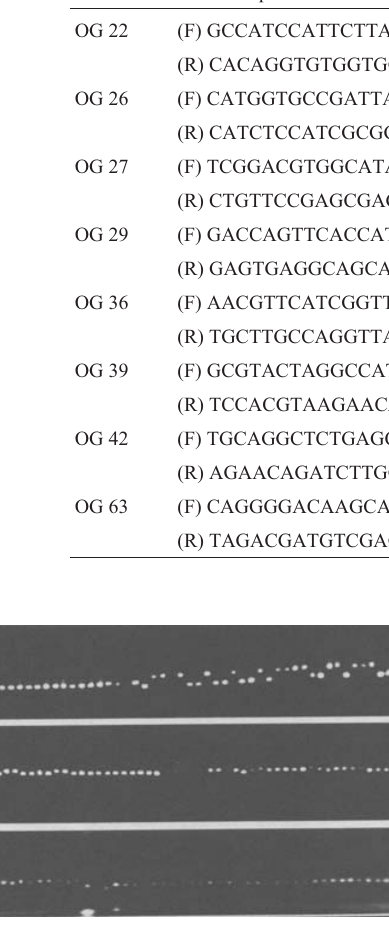
Figure 2 - Non-denaturing polyacrylamide gels of Oryza glumaepatula populations, in the following order: (A) primer OG-26, pop. PU-1 (left) and SO-4 (right); (B) primer OG-26, pop. NE-18 (left) and TA-1 (right), (C) primer OG-29, pop. PU-1 (left) and SO-4 (right). Ladders (10 bp and 100 bp) are located at the left and right sides of the gels and in the middle of gels A and